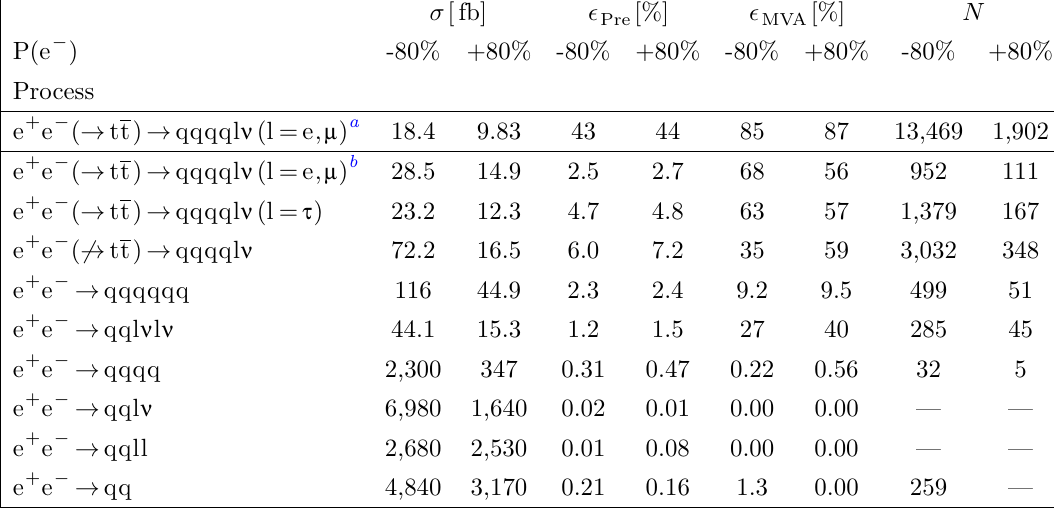
p s = 1 : 4 TeV, assuming 2 : 0 ab (cid:0) 1 p s 0 (cid:21) 1 : 2 TeV. The fractional